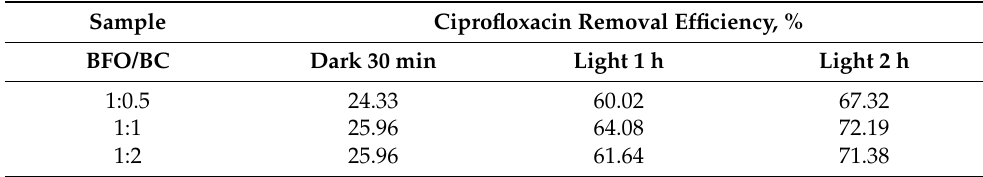
Table 2. The removal efficiency of CIP at different ratios of